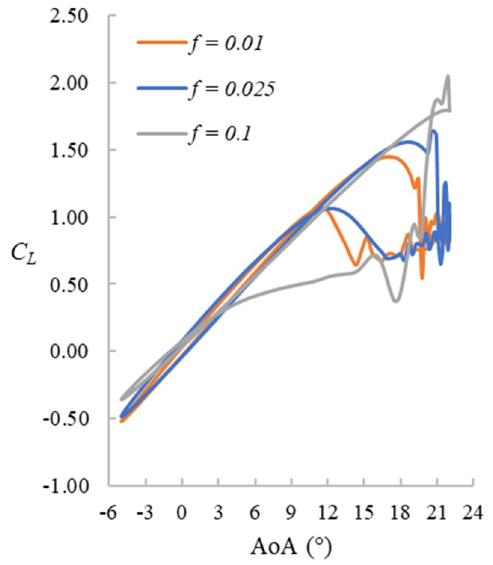
Figure 15. C L hysteresis loops. Maximum AoA = 22°, f = 0.01, 0.025, and 0.1.